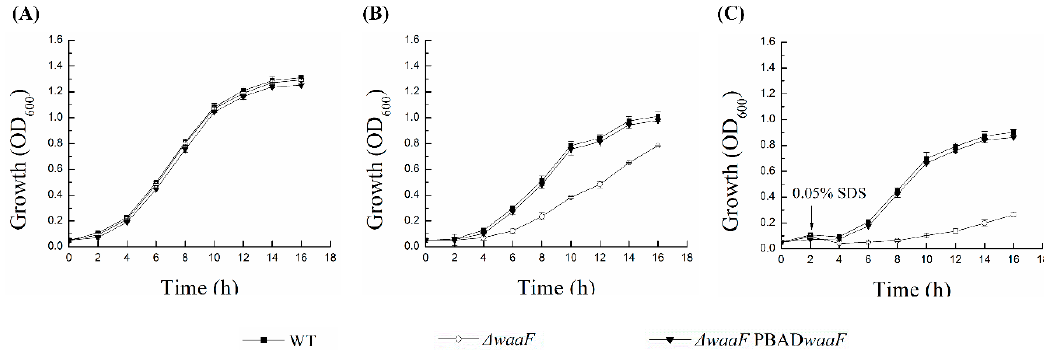
Figure 3. Effect of environmental stresses on the wild type, Δ waaF , and Δ waaF -PBAD waaF strains of Y. enterocolitica . ( A ) Growth curves of Y. enterocolitica strains without environmental stresses; ( B ) Growth curves of Y. enterocolitica strains in the presence of 0.4 μ g polymyxin B/mL; ( C ) Growth curves of Y. enterocolitica strains in the presence of 0.05% SDS. The starter cultures were incubated in Luria Broth (LB) medium supplemented with 0.6 g/L L-arabinose at 26 °C. Cell growth was measured every 2 h at 600 nm in a spectrophotometer. Data are average values and standard deviations of triplicate experiments.